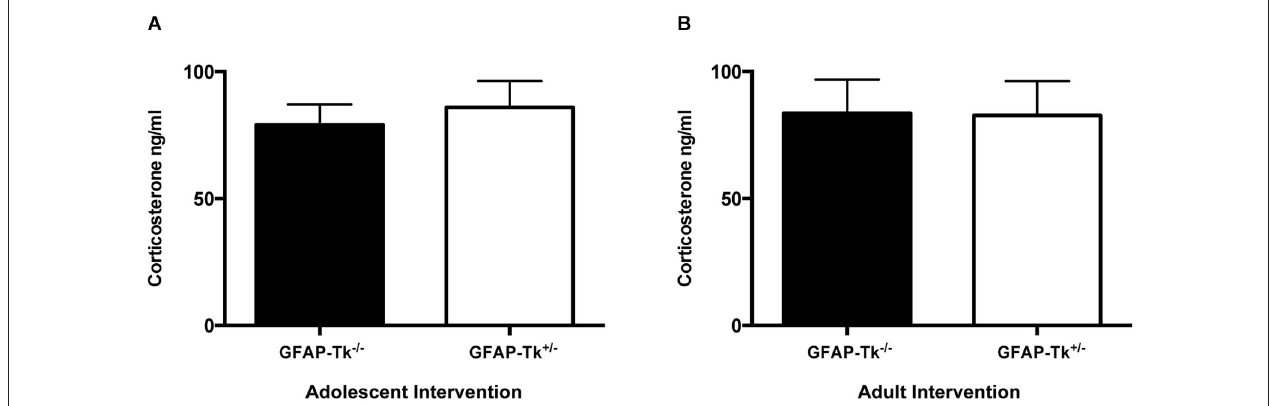
FIGURE 5 | Following a mild stressor, novel cage exposure, differences in plasma corticosterone were not detected between GFAP-TK − / − and GFAP-Tk + / − mice in (A) adolescent or (B) adult groups . Bars represent mean ± SEM for adolescent cohort GFAP-Tk − / − n = 15, GFAP-Tk + / − n = 18, Adult